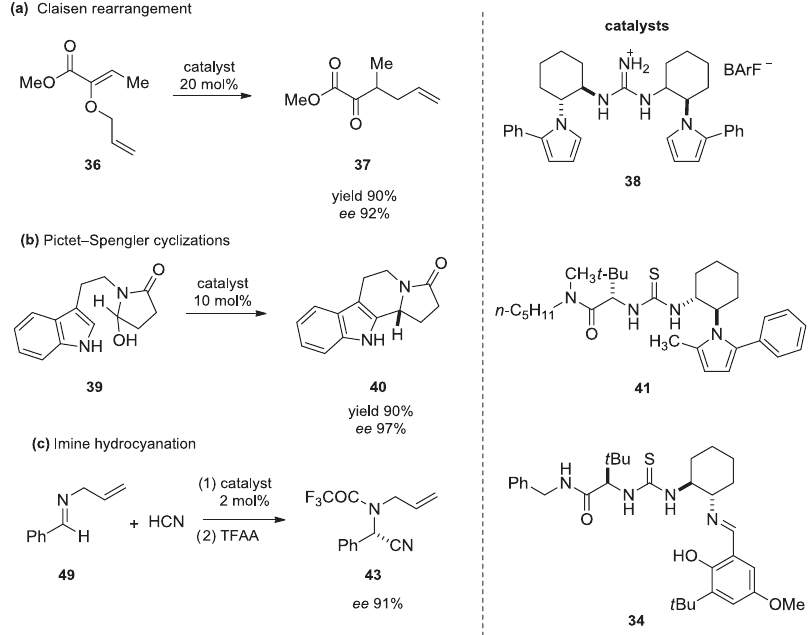
Figure 12. Examples of reactions catalyzed by H-bonding catalysts: (a) from Ref. [53], (b) from Ref. [54], (c) from Ref. [55].